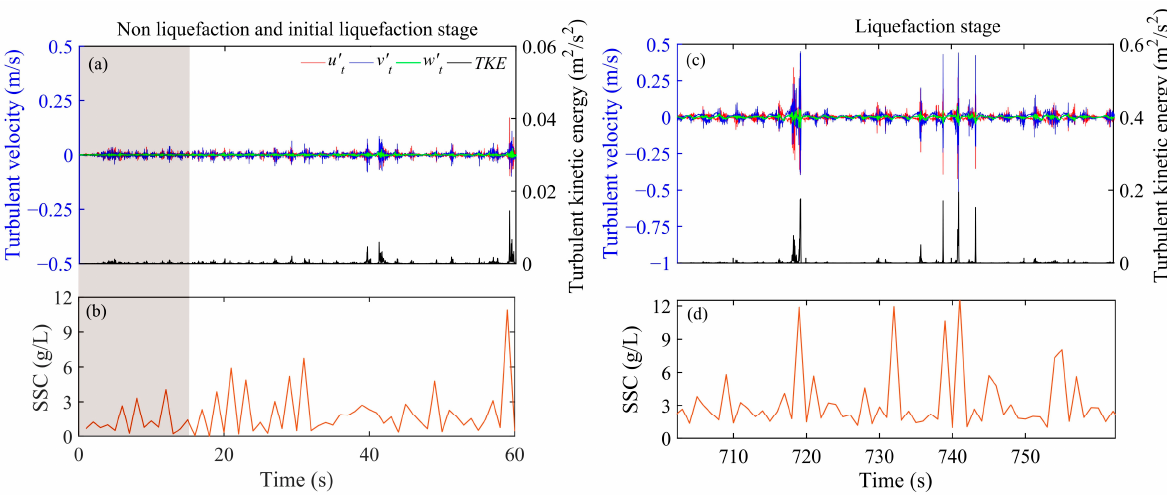
Figure 12. Time-variation of the turbulent velocity, TKE , and SSC (at 2 cm above the seabed): ( a , b ) are the nonliquefied state and the initial stage of the liquefied state, respectively, where u’ t , v’ t , and w’ t represent the longitudinal, transverse, and vertical components of the turbulence, and TKE is the turbulent kinetic energy; ( c , d ) represent the later stages of liquefaction.